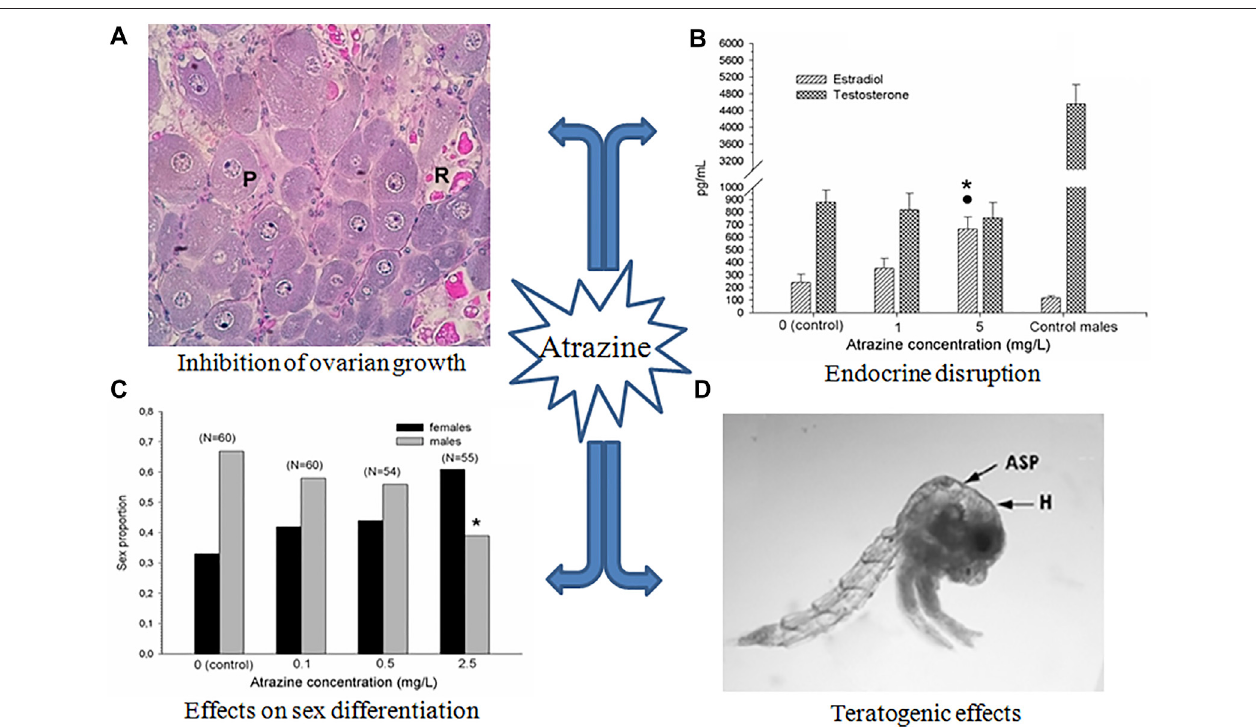
FIGURE 1 | Main effects of atrazine on crustacean reproduction. (A) Relative proportion of oocyte types in the ovary of N. granulata after 3 months of exposure (P: previtellogenic, and R: reabsorbed vitellogenic oocytes; no normal vitellogenic oocytes developed). Modi fi ed from Silveyra et al. (2017). (B) Changes in steroid in the hemolymph of Procambarus clarkii after 1 month of exposure. Asterisk and dot indicate signi fi cant differences ( p < 0.05) with respect to control and the lowest concentration, respectively; control male data are also included for comparative purposes. From Silveyra et al. (2019). (C) Proportion of sex in early juveniles of Cherax quadricarinatus exposed during 4 weeks. Asterisk indicates signi fi cant differences ( p < 0.05) with respect to control; number of animals is indicated between brackets.FromMacLoughlinetal.(2016). (D) zoeaIfromhatchedfromovigerousfemalesof N.granulata exposedduringtheentireeggincubationperiod(H:hydropsy; ASP:atrophieddorsalspine;melanization,atrophyofsetae,andatrophiedeyescanbealsoobserved).Modi fi edfromÁlvarezetal.(2015).All fi guresarereproducedwith